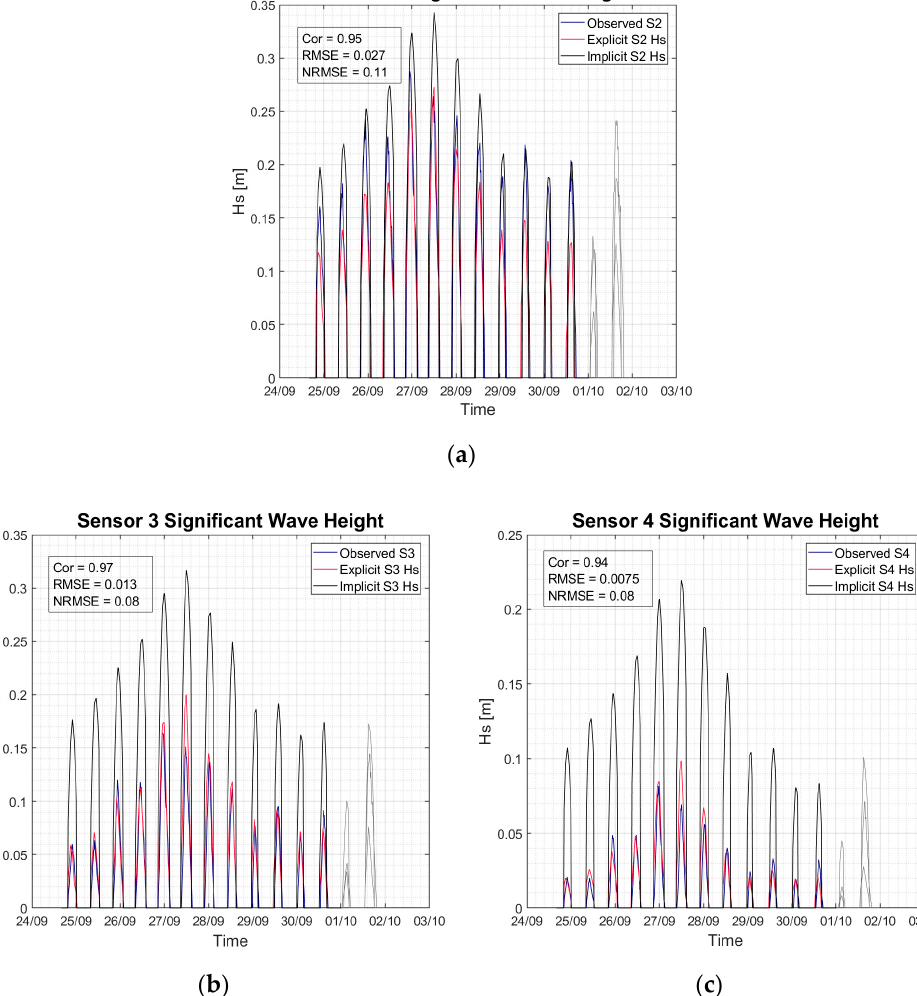
Figure 8. Comparison between the Hs at each sensor, for both Implicit and Explicit representations. The legend in the top right shows the correlation coefficient (Cor) and normalized root mean square error of each sensor (NRMSE). Panels ( a – c ) show the results for Sensor 2, 3 and 4, respectively.